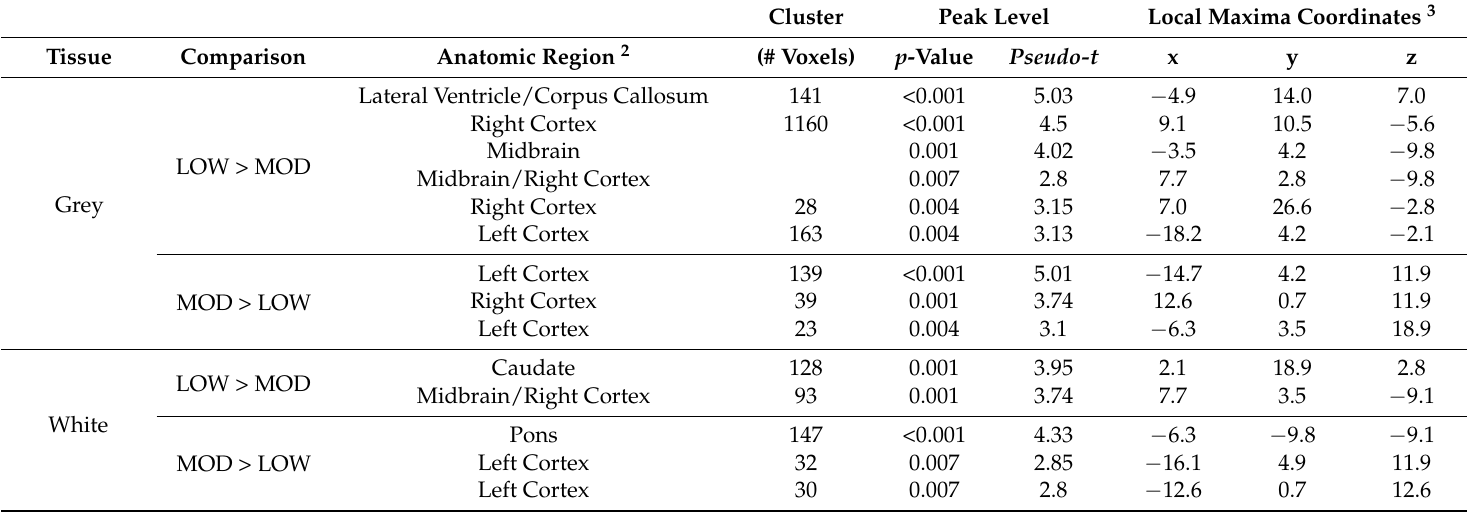
Table 1. Voxel-based morphometry comparison between pigs provided LOW and MOD dietary sialyllactose 1